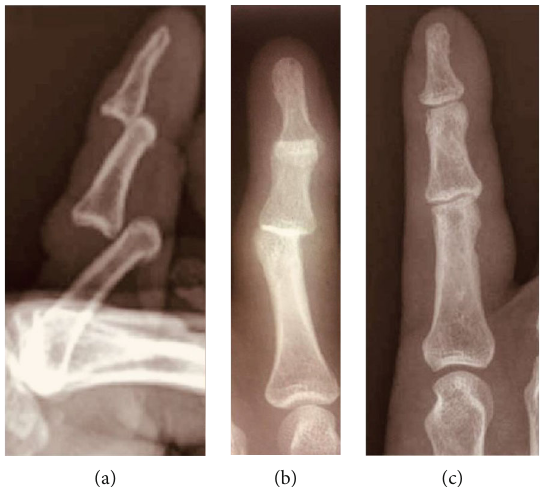
Figure 2: Anteroposterior and lateral radiographs (a, b) demonstrating dorsal dislocation of both proximal and distal interphalangeal joints, without any bony avulsion fracture. Postreduction radiograph (c) con fi rms that all joints are well